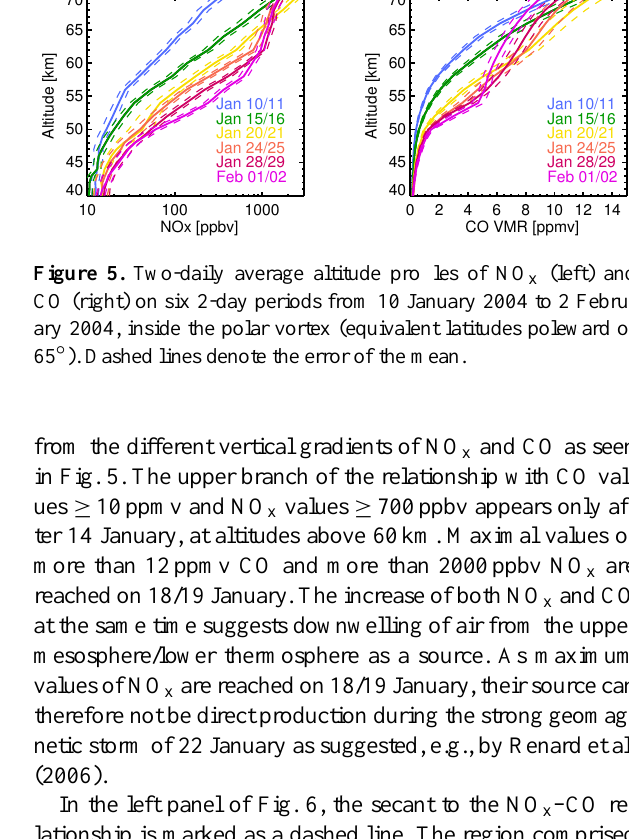
Fig. 4. Blue squares: temporal evolution of the peak altitude of NOx as observed in MIPAS observations inside the polar vortex (equivalent latitudes polewards of 65 ◦ N), from January through March 2004. The red line is the result of a least-square fit to those observations, giving an average subsidence rate of 400m/day for the NOx maximum.